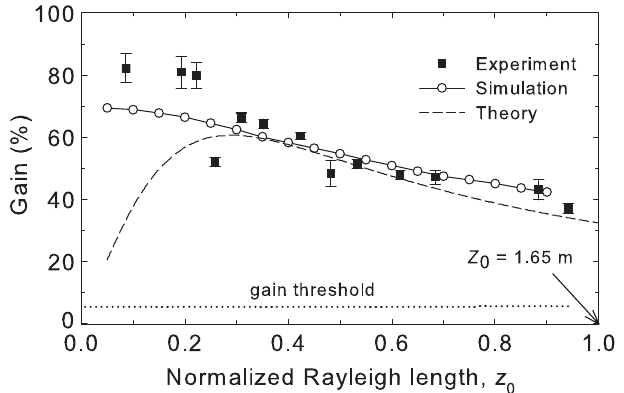
FIG. 2. Dependence of gain on normalized Rayleigh length z 0 . The dashed line is derived from Eq. (1). The dotted line is the cavity loss due to output coupling (5.9%); the gain must at least overcome this loss. The dimensional Rayleigh length at z 0 ¼ 1 is ¼ 1 : 65 m . Z 0